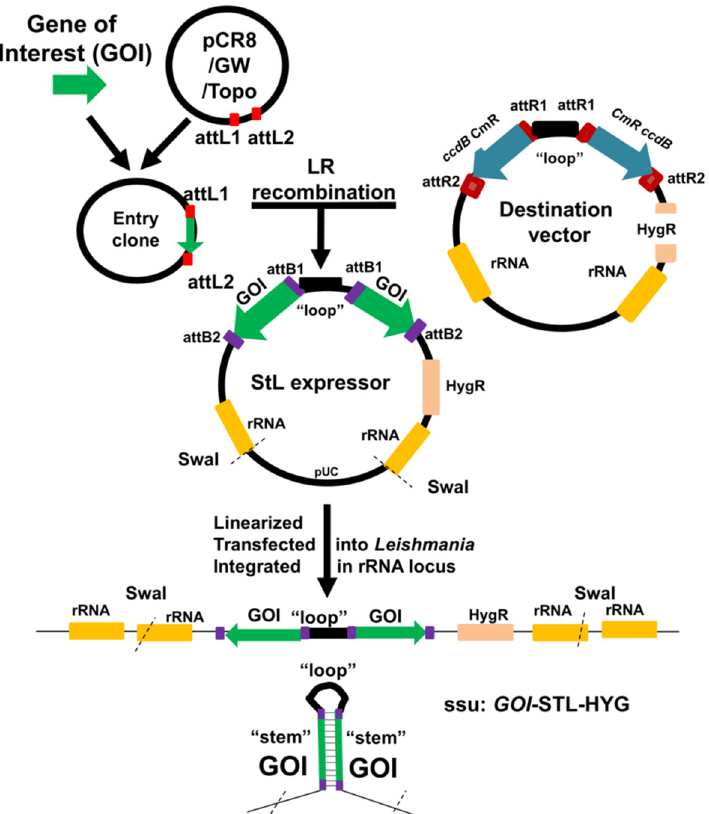
Figure 1. Flowchart for generation of entry and StL constructs using Gateway site-specific recombinase technology followed by introduction into Leishmania to express dsRNA. A stem for each GOI (gene of interest) was amplified by PCR and then cloned into pCR8/GW/TOPO vector (Invitrogen) to generate an “entry” clone bearing a flanking attL 1 and attL 2 sites for recombination-based transfer. The pIR-GW destination vectors bear two opposing ccdB/CmR cassettes, each flanked by attR 1 and attR 2 sites. Following site-specific recombination by the Gateway LR reaction, the desired StL for each GOI was obtained and confirmed. For biological tests, each StL DNA was linearized with Swa I, electroporated into Leishmania , where it integrated into the small subunit ribosomal RNA locus (SSU). There it is transcribed by the strong rRNA pol I promoter to generate RNAs whose dsRNA regions are processed by the RNAi